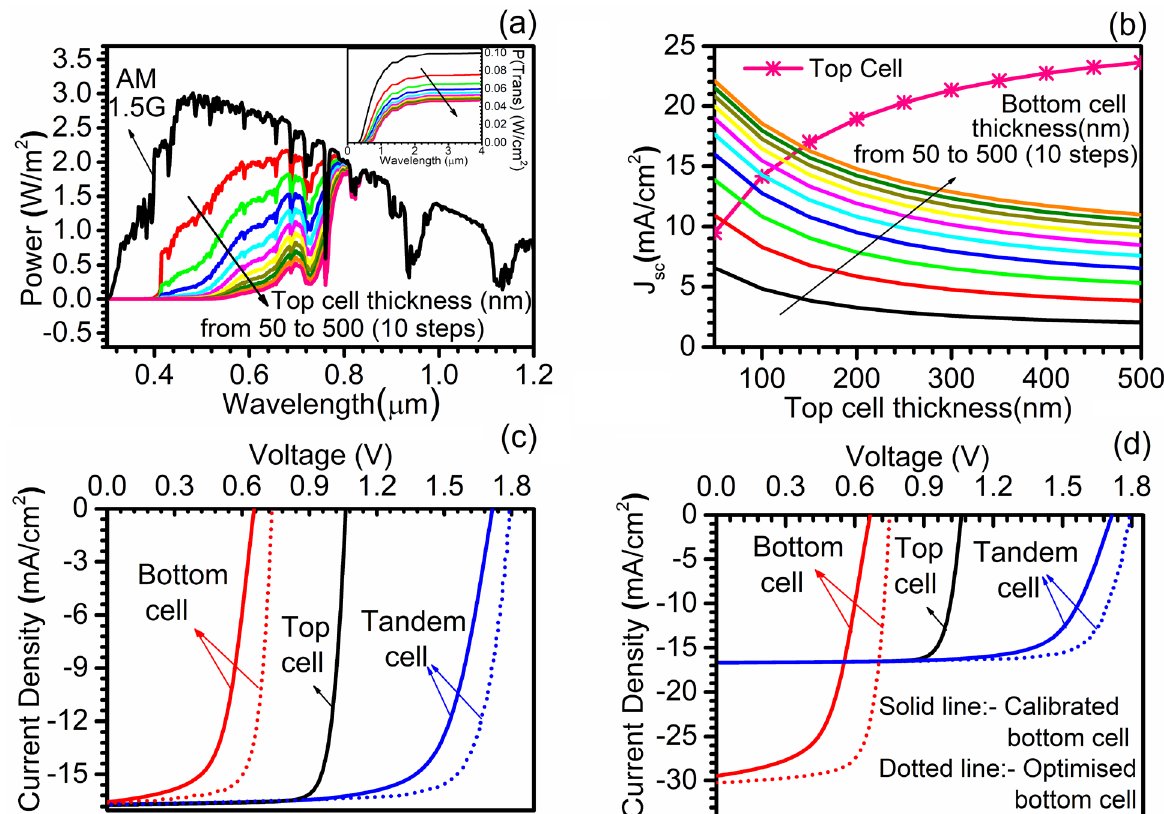
Figure 7. ( a ) Power transmitted by the top cell at different thickness along with standard AM1.5G spectrum, ( b ) current matching curve at the different top and calibrated bottom cell, ( c ) JV curve for standalone top cell, standalone bottom cell (calibrated and optimized), and tandem (with calibrated and optimized bottom subcell) solar cell and ( d ) JV curve for top cell and bottom cell (calibrated and optimized) under standalone (AM1.5G spectrum), the final tandem J–V curve with calibrated and optimized cell is also shown. Data reported in figures are obtained from the SCAPS-1D sub-cell so as to measure its performance. Concurrently the thickness of PbS-TBAI of the bottom cell is also varied in 10 equal steps from 50 to 500 nm in order to calculate all the possible thickness value points where current matching could be possible. This effort resulted in the formation of current matching, i.e., J SC matching curve as shown in Fig. 7(b) at various thickness of the top and bottom subcells. The result shows that the current matching is not observed for the thickness of both cells equivalent to 50 nm and for the perovskite thickness more than 150 nm. Whereas nine (9) intersecting points are observed for the perovskite thickness range 50 nm to 150 nm and PbS-TBAI thickness range 100 nm to 500 nm. Among them, the last current matching point has opted to deliver the maximum tandem J SC of 16.62 mA cm −2 and the corresponding top and bottom subcell thickness 143 nm and 500 nm, respectively. After identifying the corresponding top and bottom subcell thickness to get maximum J SC from the tandem device, the top cell is re-simulated with thickness 143 nm under standard AM1.5G spectrum, and another filtered spectrum is constructed with said thickness. The same filtered spectrum has been used to illuminate the bottom subcell with a thickness of 500 nm to obtain the illuminated J–V of the bottom subcell under tandem configura- tion. The J–V curve for both top cell (143 nm) under AM1.5G spectrum and bottom cell (500 nm) under filtered spectrum is depicted in Fig. 7(c), which validates the equal current, i.e., current matching in both top and bottom subcells. Followed by current matching, the tandem J–V curve is constructed by adding the voltage (x-axis) at equal current points (y-axis) to construct the tandem J–V curve, which is shown alongside the individual J–V curve in Fig. 7(c). The solid line tandem curve shown in Fig. 7(c-d) is constructed using calibrated PbS-CQD bottom subcell having PbS-TBAI thickness of 500 nm and showed the tandem conversion efficiency of 20.57% with V OC (1.714 V), J SC (16.62 mA cm −2 ), and FF (72.3%). It should be noted that the constructed tandem device did not contain the optimized bottom subcell in terms of doping density of PbS-EDT (HTL) and MZO (ETL). Therefore, to further enhance the conversion efficiency of the tandem device, the optimized doping 5 × 10 17 cm −3 is used for both HTL and ETL layers in the bottom subcell. The detailed discussion related to the optimization of the doping level in the bottom subcell is reported in our previous work published elsewhere 45 . In standalone configuration the calibrated bottom cell with thickness 500 nm showed 11.24% conversion efficiency with V OC (666 mV), J SC (29.64 mA cm −2 ) and FF (56.9%) whereas optimized bottom cell reflected 16.88% conversion efficiency with V OC (752 mV), J SC (30.77 mA cm −2 ) and FF